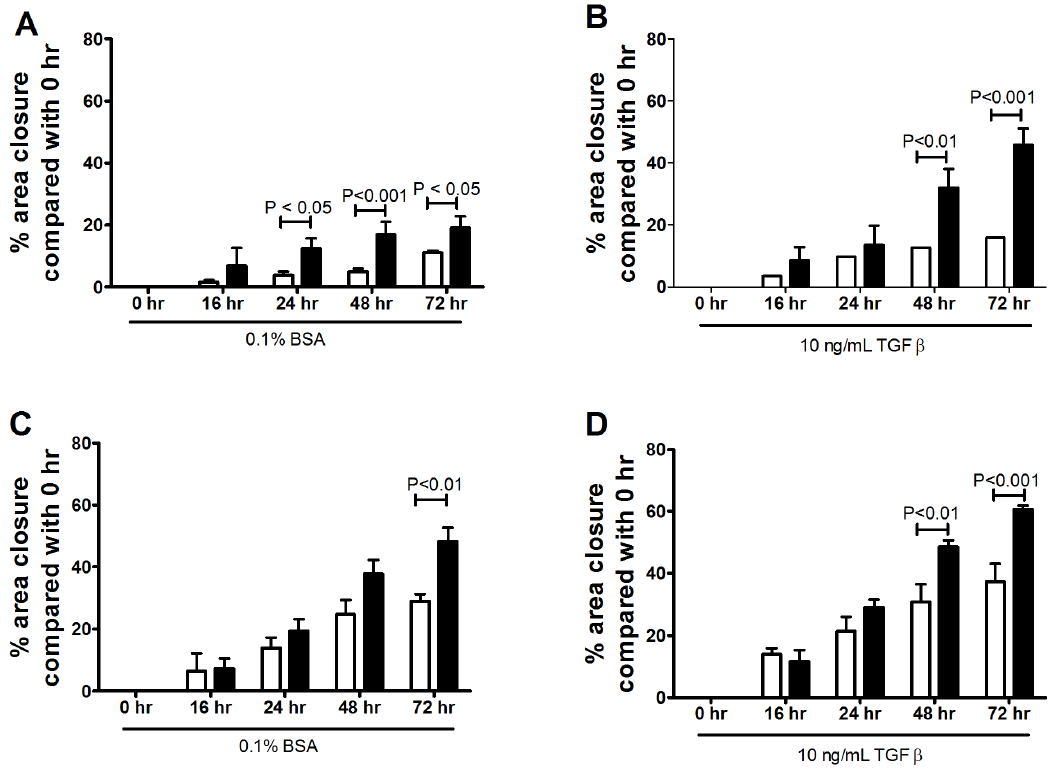
Figure 5. Wound healing is enhanced in asthmatic ASM cells. The degree of closure, measured over time, of a 1cm wound induced in non- asthmatic (white, n=3–4) or asthmatic (black, n=3–4) unstimulated (A) or TGF b stimulated (B) ASM cells. The cells were reseeded on an ECM deposited by an asthmatic ASM cell line in the absence (C) or presence (D) of TGF b . Data are expressed as mean 6 SEM.